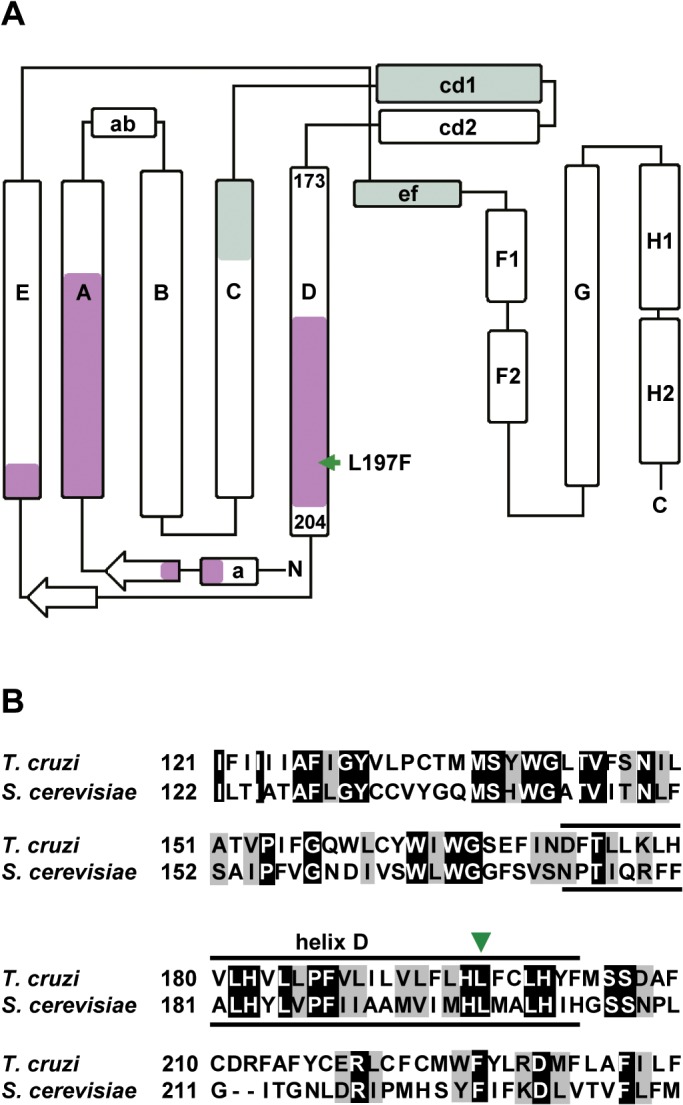
GNF7686 resistance-conferring mutation in T. cruzi cytochrome b structure.A) Secondary structure of yeast cytochrome b (adapted from Ding et al. 2006 and Fisher et al. 2008, [50, 57]) with amino acid sequence stretches that form QP and QN ubiquinol-binding sites highlighted (green and violet, respectively). The amino acid indicated by a green arrow corresponds to the L197F mutation (equivalent to L198F in S. cerevisiae) present in the GNF7686-resistant T. cruzi strain. B) Alignment of S cerevisiae and T. cruzi cytochrome b amino acid sequence around L197F mutation. Identical amino acids are highlighted in black and conserved substitutions are highlighted in grey.